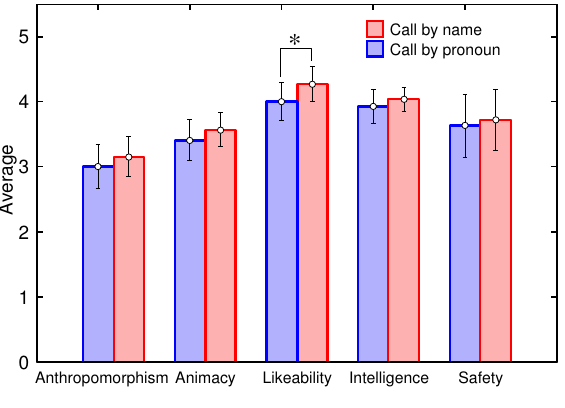
Figure 14. Evaluation